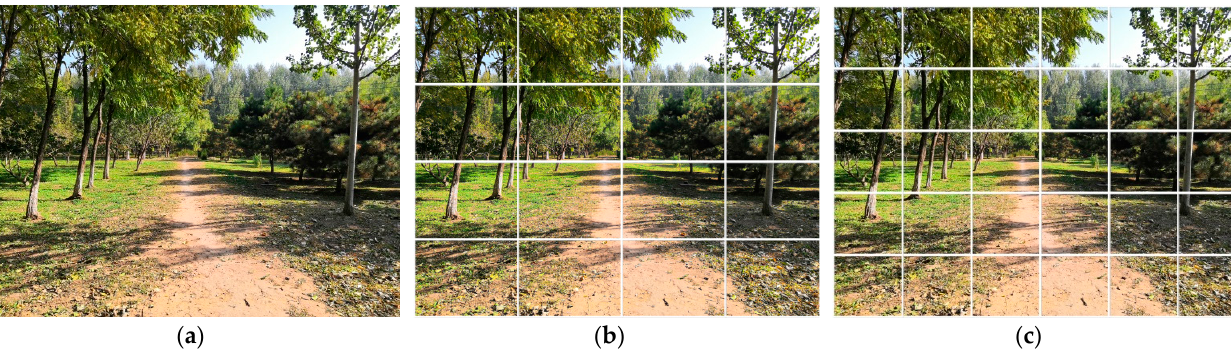
Figure 3. Superpixel initial segmentation effect diagram based on the image collected by the CCD monocular vision camera. ( a ) Raw image; ( b ) Initial segmentations with 4 × 4; ( c ) Initial segmentations with 6 × 5.